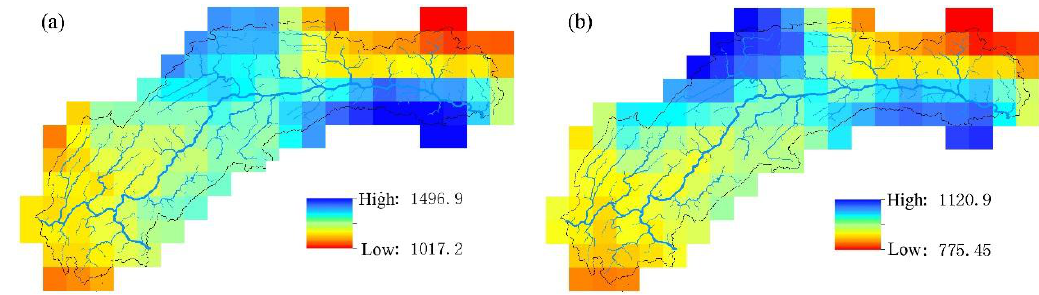
Figure 2. TRMM satellite data in the study area (( a ) TRMM multi-year average annual precipitation; ( b ) TRMM multi-year average flood season precipitation).